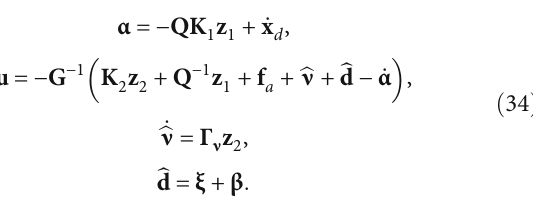
Figure 1: Pirouette